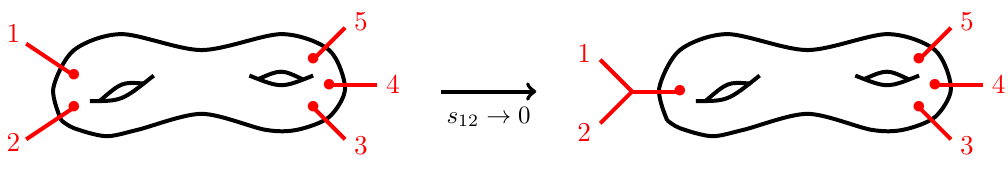
Figure 2 . Factorization of the genus-two (cid:12)ve-point amplitude onto a massless intermediate state in the s 12 -channel into the tree-level 3-point function and the genus-two 4-point function with massless external